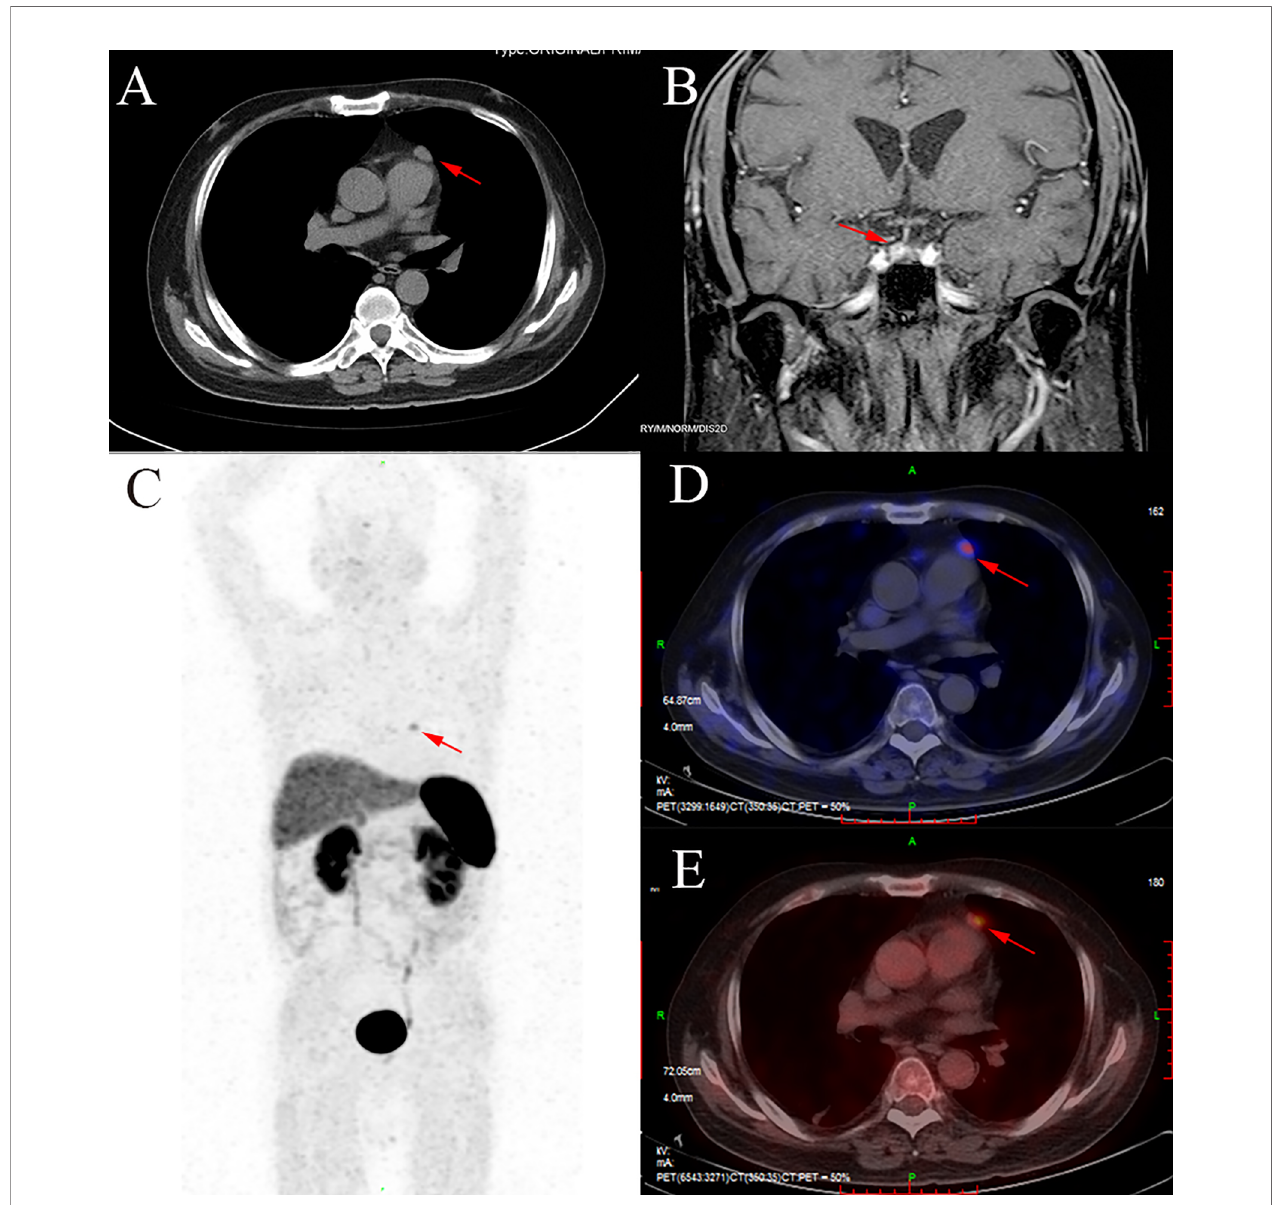
FIGURE 1 | The CT, MRI, and PET/CT images of this patient. (A) A soft tissue density nodule in the mediastinum (red arrow). (B) A nodule in the right side of the pituitary (red arrow). (C, D) The anterior mediastinal nodule with increased 68 Ga uptake (red arrow). (E) The anterior mediastinal nodule with increased fl uorodeoxyglucose uptake (red